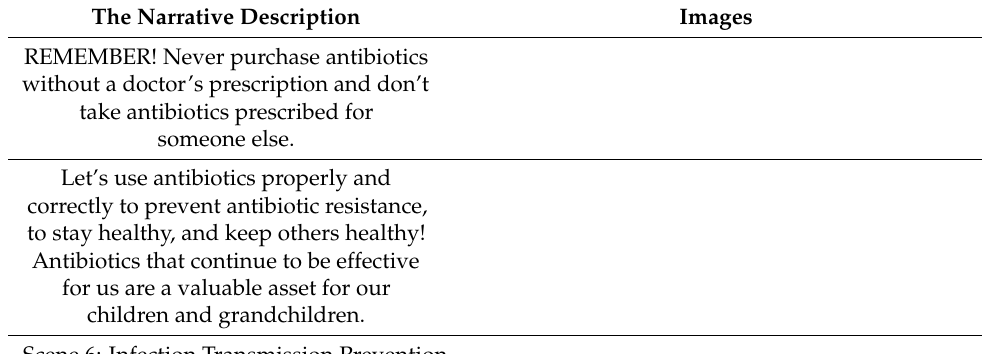
Illustration of hand-washing steps